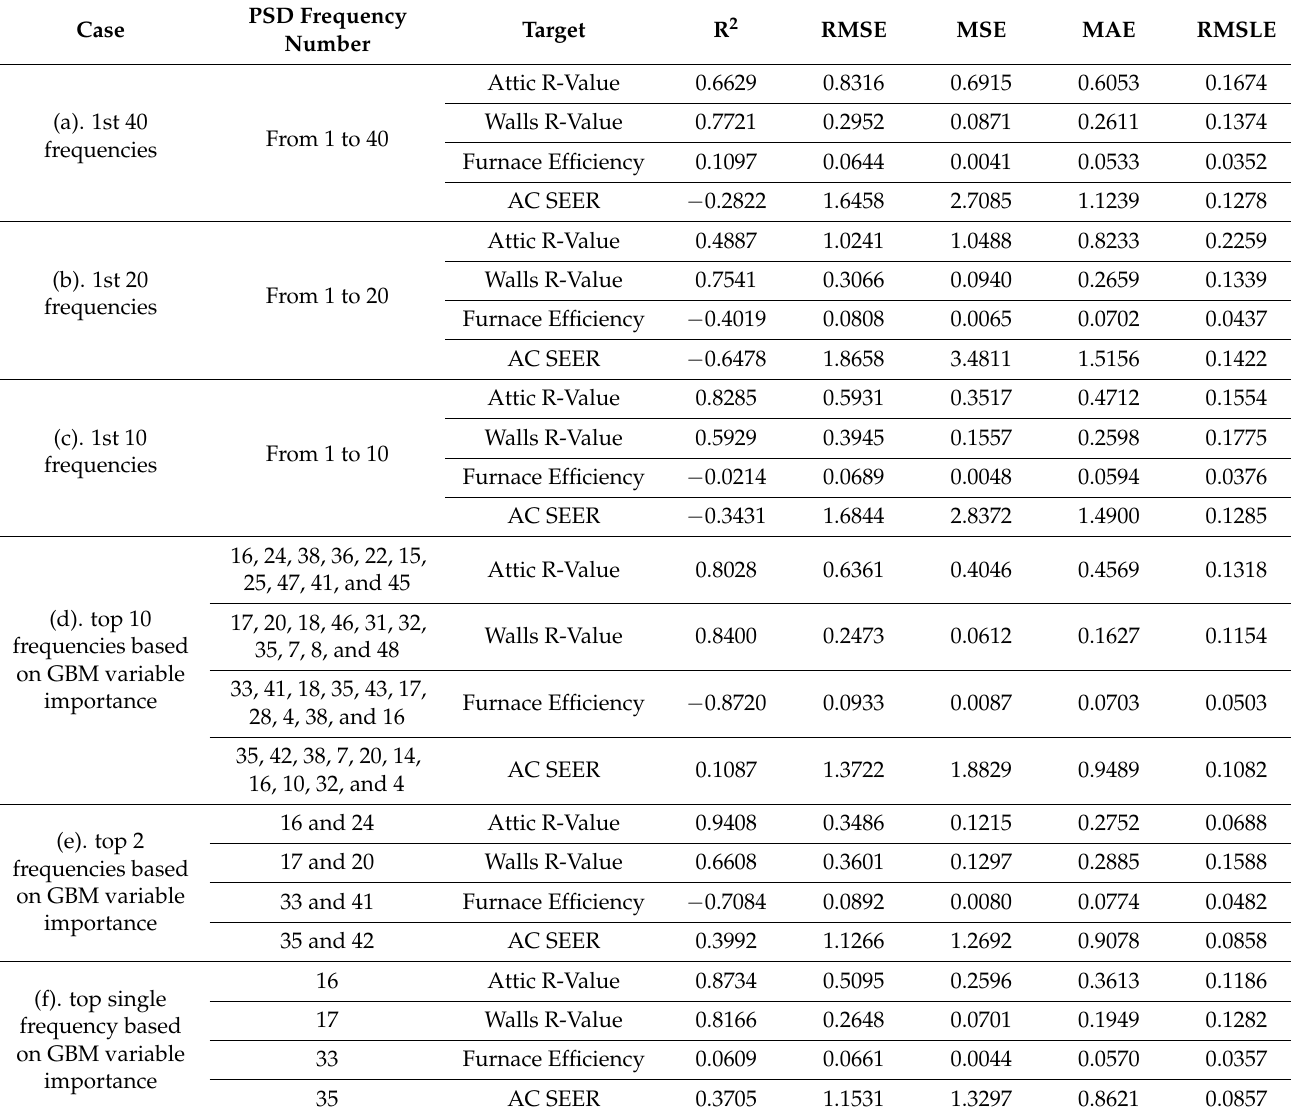
Table 6. Power spectrum density (PSD) frequency cases with model prediction evaluation parameters for the testing